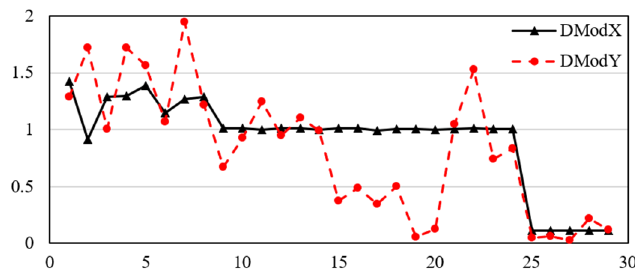
Figure 8. Construction quality of M2.